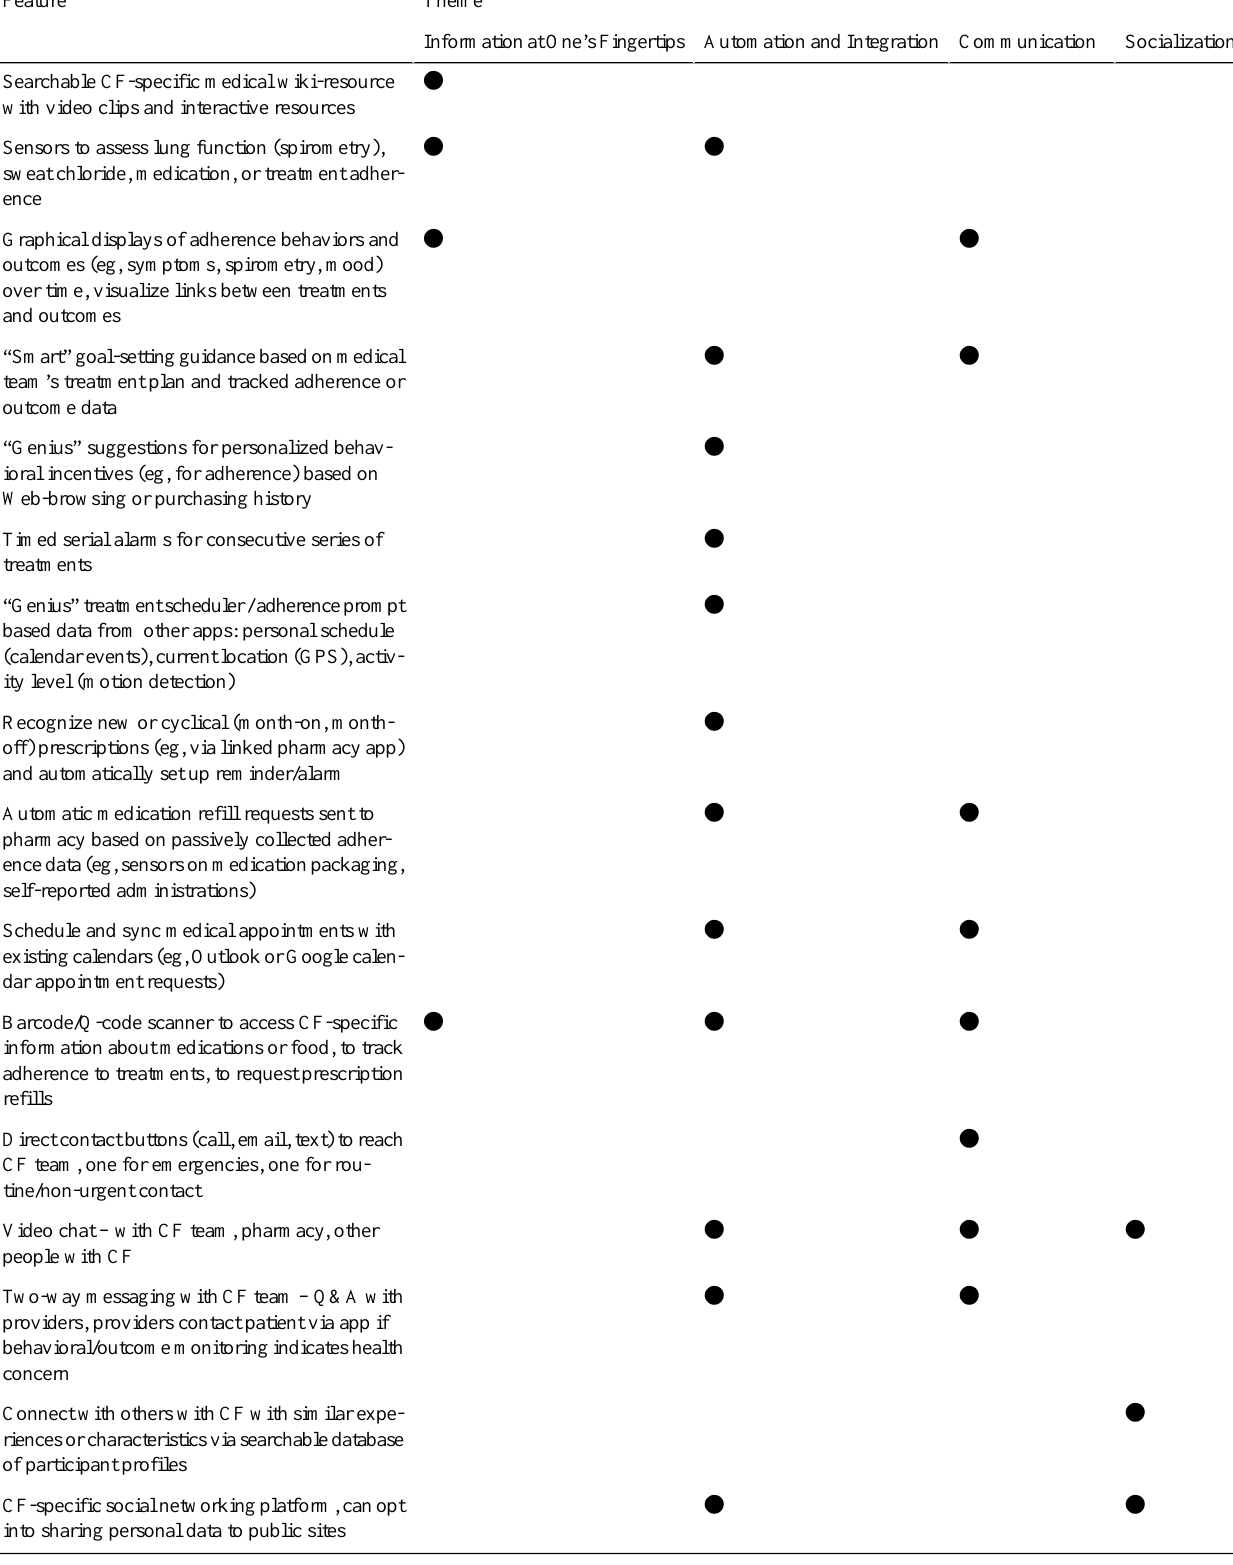
Table 6. Suggested app features related to cross-cutting themes.